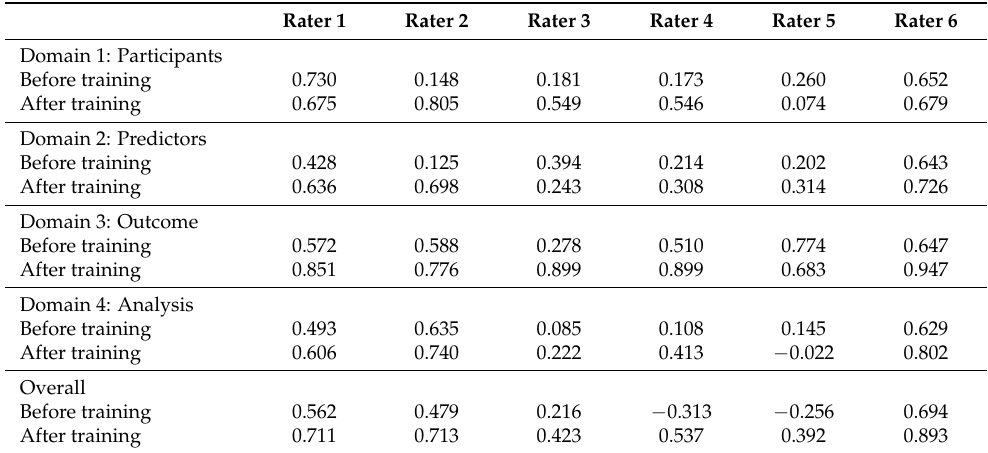
Table 1. Agreement in terms of AC 1 estimates between individual raters and consensus decision before and after training for the domain-specific and overall ROB rating.